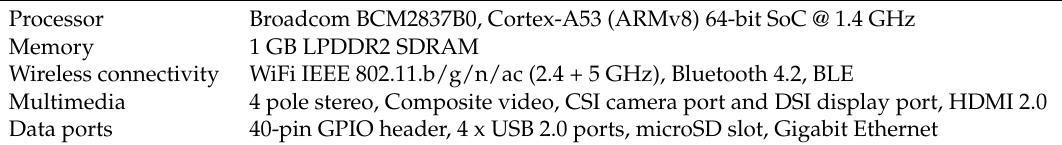
Table 1. Technical characteristics of the Raspberry Pi 3 Model B+.